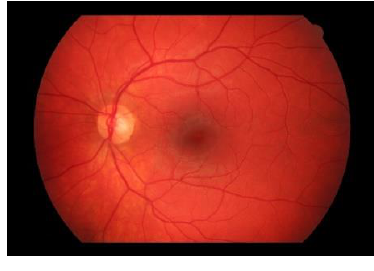
Figure 5.a. Input image